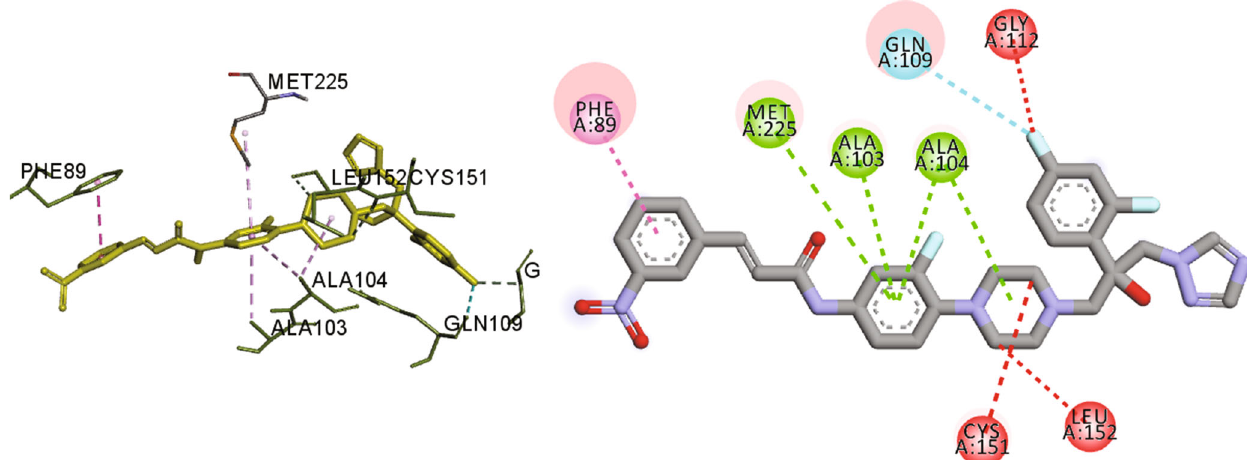
Figure 4: 2D and 3D interactions of ligand 32 in cytochrome P halogen bond, red: carbon-hydrogen, purple: